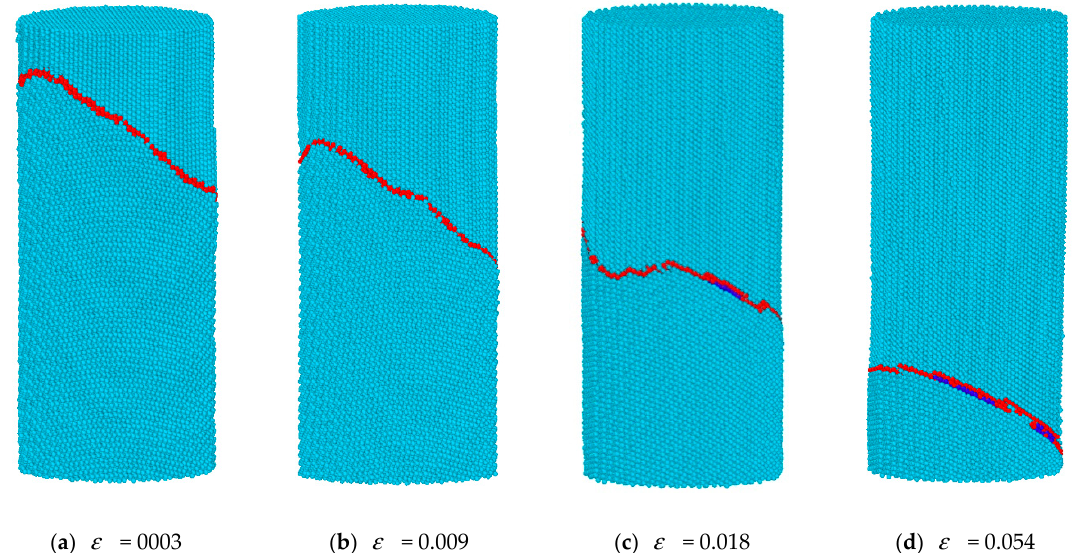
Figure 4. Bi-crystal Mg nanopillar for which atoms in the TB are not fixed.